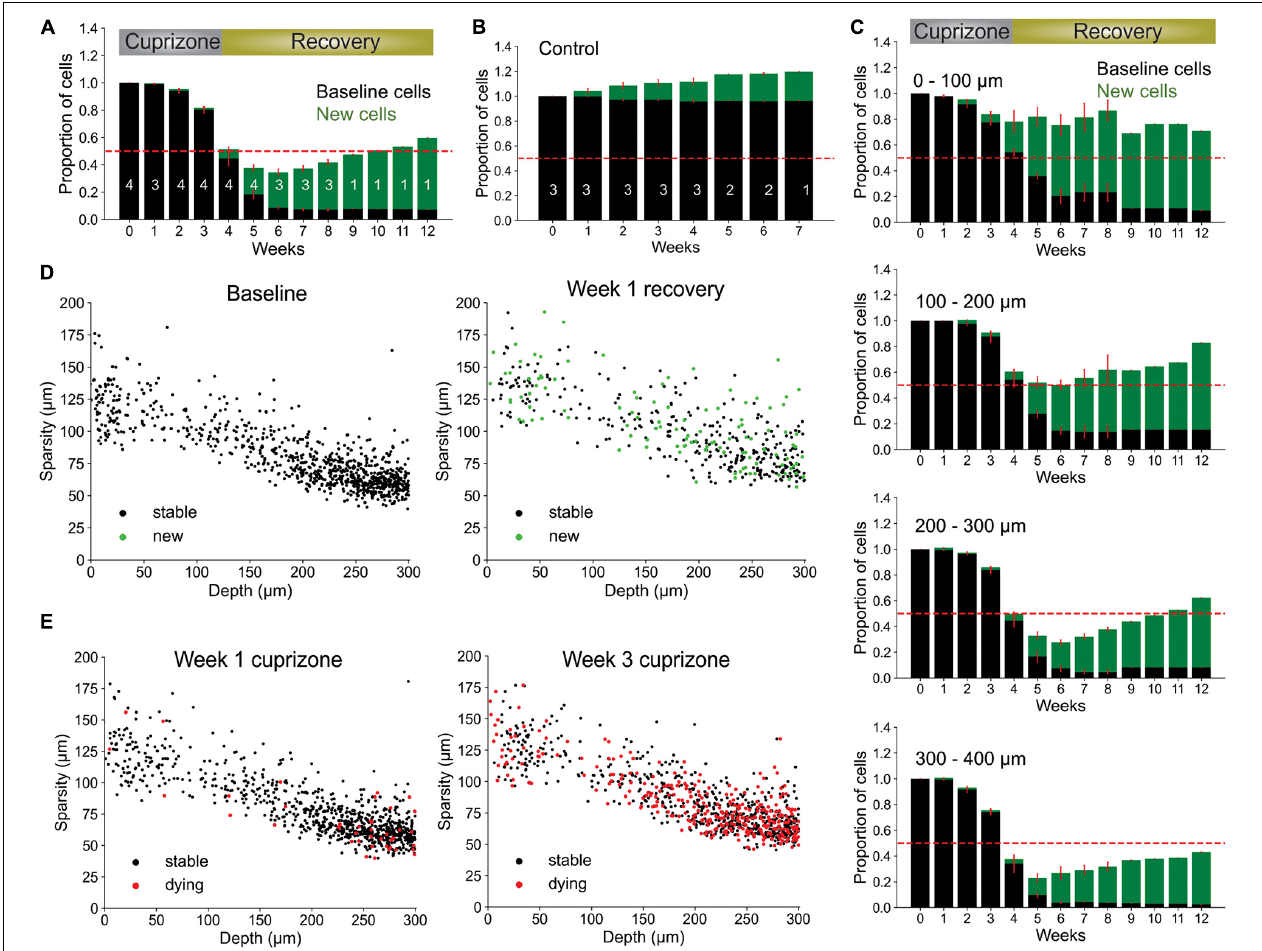
FIGURE 6 | Local oligodendrocyte density does not correlate with region specific suppression of regeneration. (A) Normalized values for baseline and newly formed oligodendrocytes across weeks of cuprizone treatment and recovery. Bars indicate cell numbers averaged across animals for each week. (B) Normalized values for baseline and newly formed cells in no treatment condition. (C) Cortical depth-specific changes in oligodendrocyte regeneration showing suppressed regeneration in deeper layers. Volume split into four sections based on depth (0–100 µ m, 100–200 µ m, 200–300 µ m, and 300–400 µ m). (D) Cell sparsity (average distance to 10 nearest neighbors) of stable and newly formed oligodendrocytes at baseline and week 2 of recovery shows no obvious clustering patterns at any timepoint. (E) Sparsity of cells that will die within 1 week (red) at week 1 and week 3 of cuprizone also shows no obvious clustering patterns at any timepoint. Cells pooled from n = 4 cuprizone treated and n = 3 control